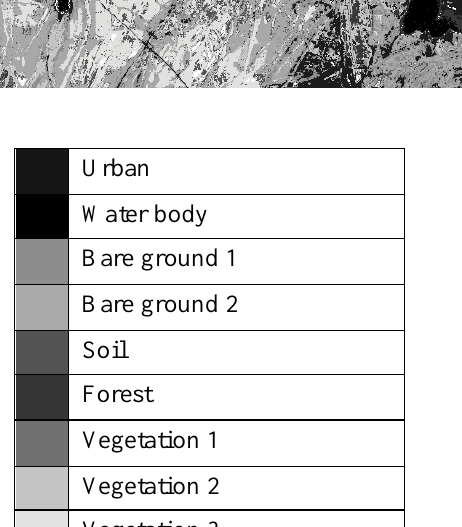
Figure 2 Classified image for target